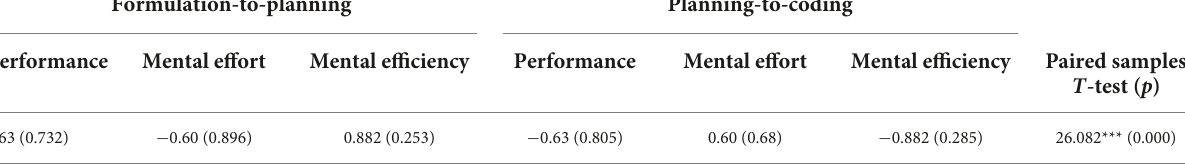
TABLE 3 Standardized problem-solving performance, standardized mental effort, and mental efficiency scores–mean (standard deviation) and paired samples t -test ( p